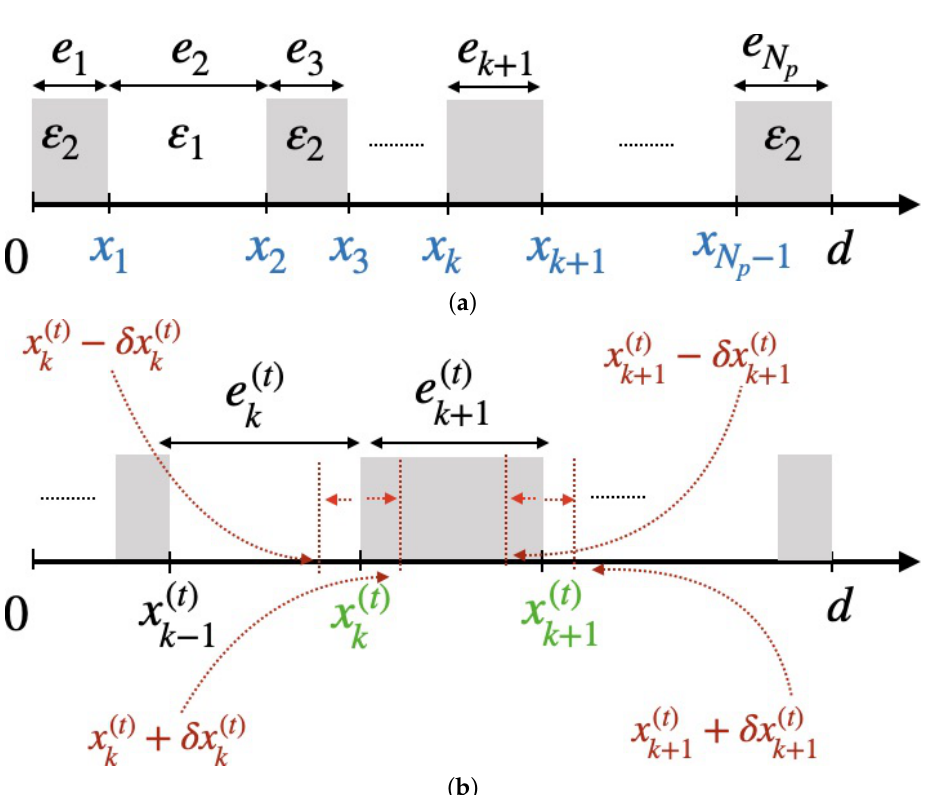
Figure 1. ( a ) Sketch of variables e k distribution. ( b ) Sketch of design variables x k . In the proposed optimization process, the increment of x k increasing favorably the FOM is kept as the best current optimal